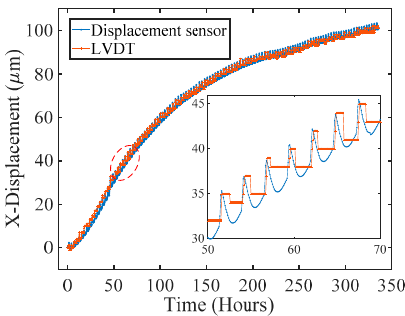
Figure 8. The displacement along the X direction measured by our prototype sensor and the LVDT. The inset shows the data collected during a period between 50 and 70